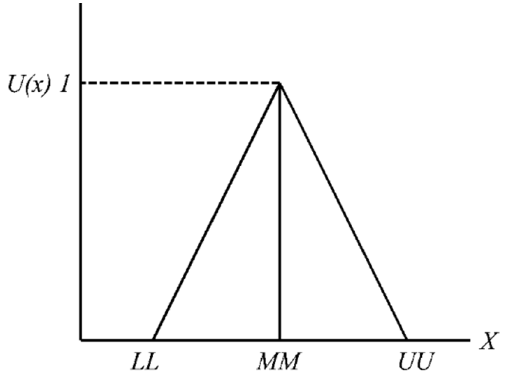
Figure 2. Triangular fuzzy numbers. Table 4. Transformation rules of linguistic scale.